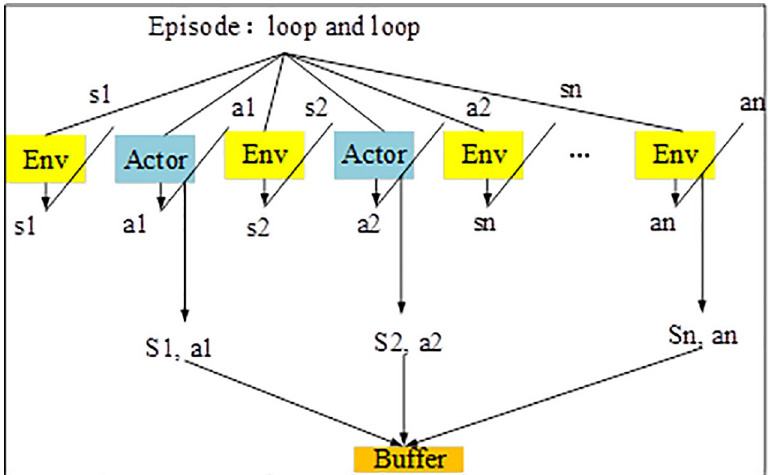
Fig 2. Flowchart of the tactical indicator in an automatic detection